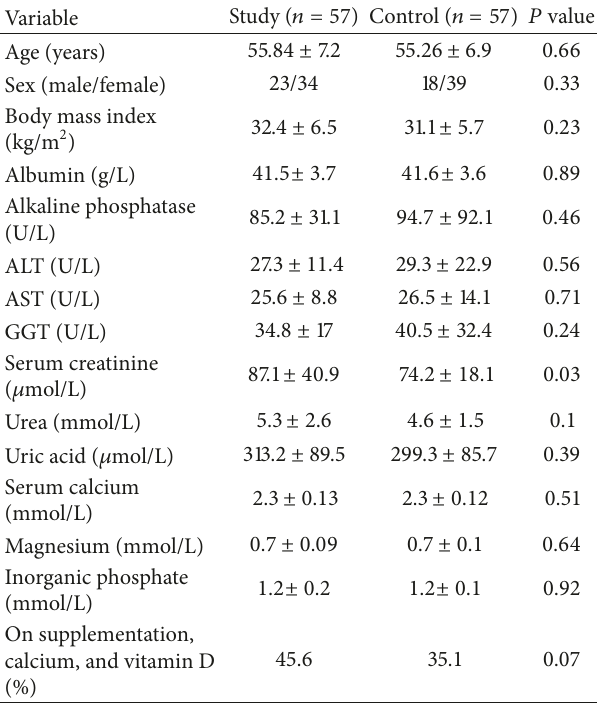
Figure 3: Flowchart of participants in the study. Table 1: Baseline characteristics of study and control groups. ALT: alanine transferase; AST: aspartate transferase; GGT: 𝛾 -glutamyl